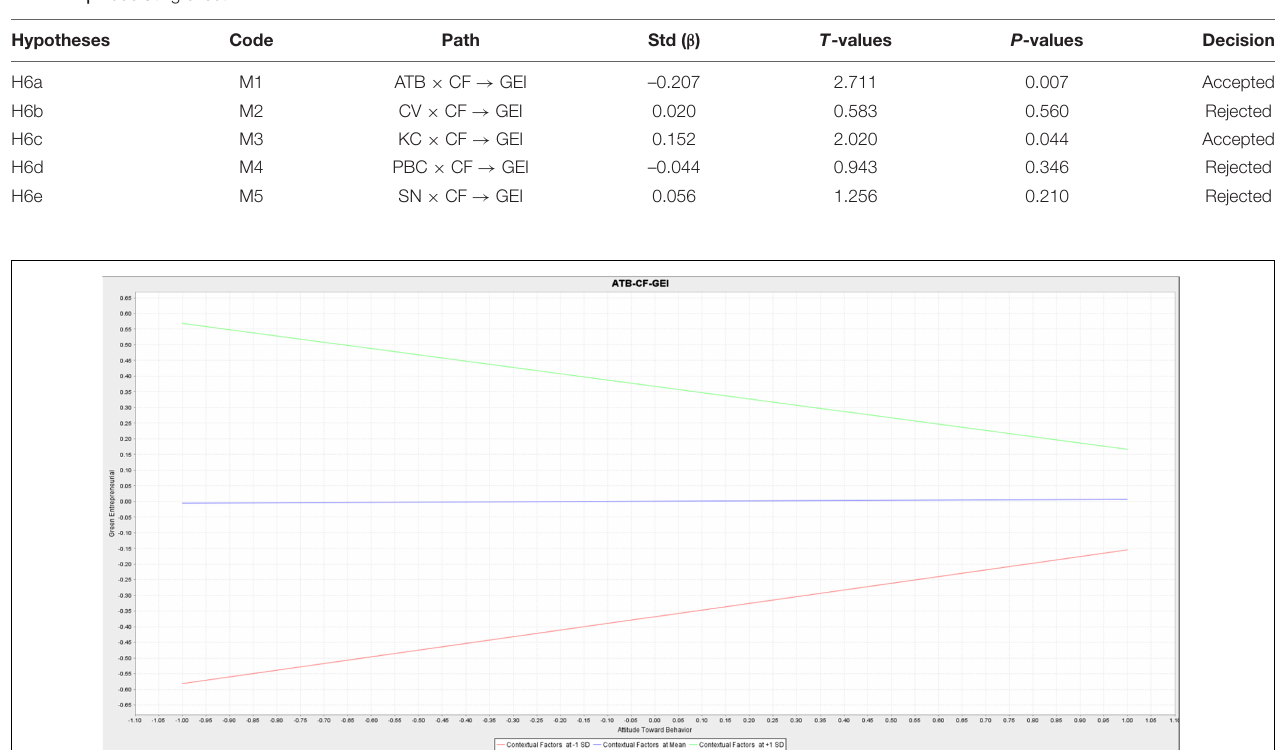
FIGURE 4 | The simple slope for the moderating effect of contextual factors on the relationship between attitudes toward behavior and entrepreneurial intentions.